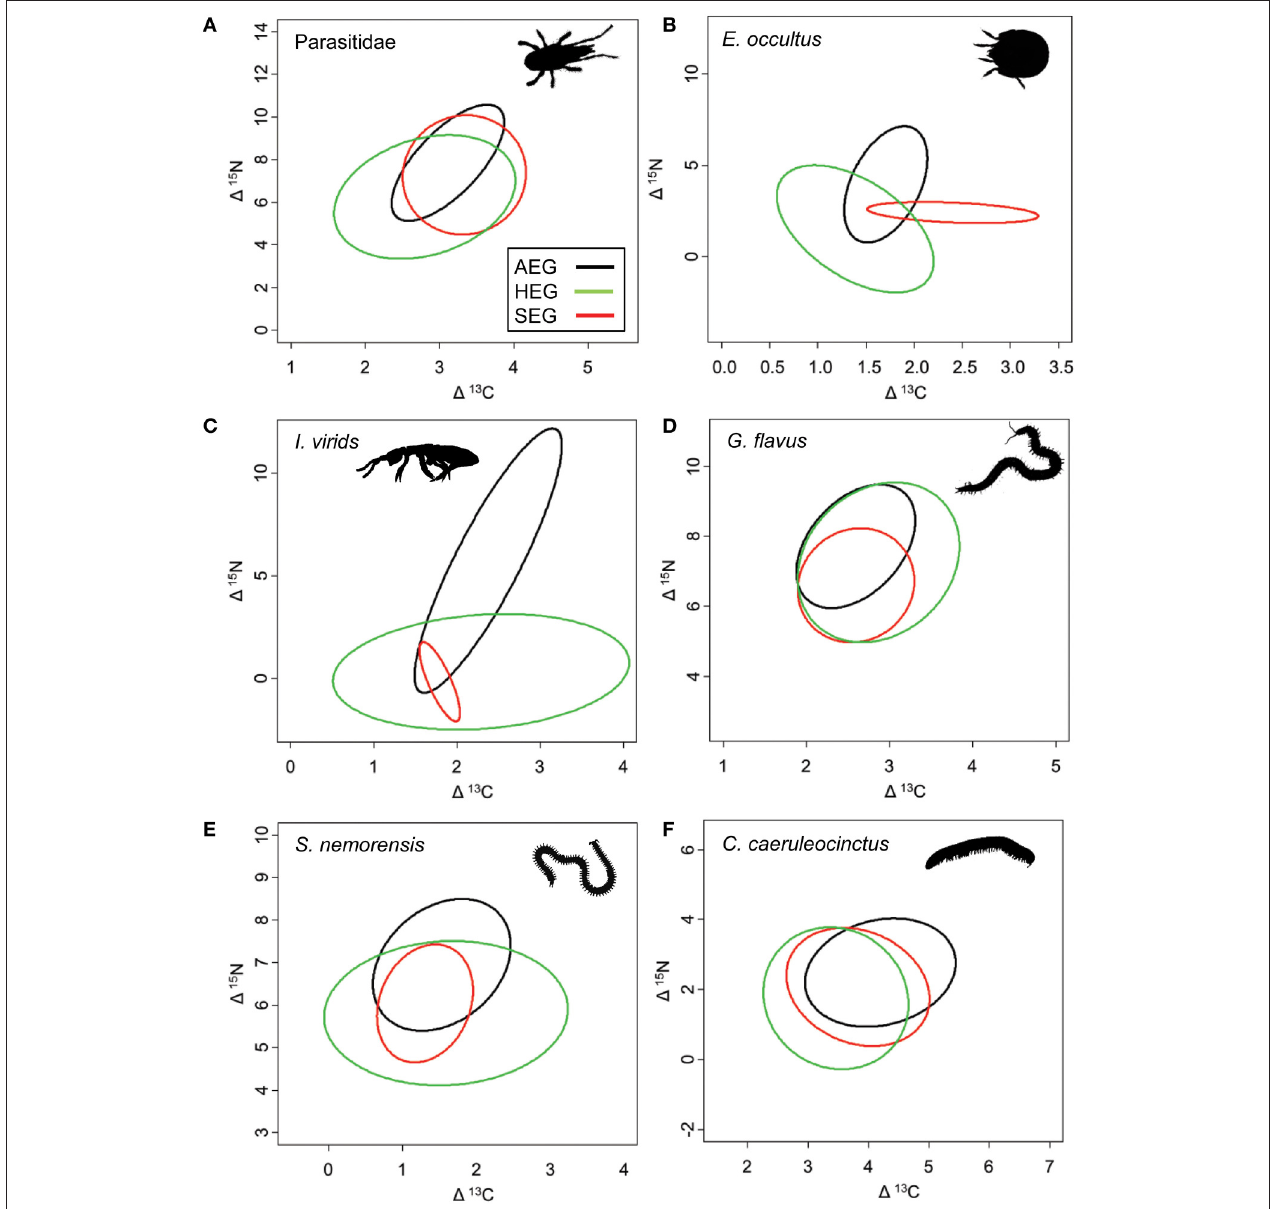
FIGURE 6 | Isotopic niches of the six soil arthropod species that were sufficiently common to calculate standardized ellipses for the feeding niches in all three study region (occurrence in a minimum of three sites per region; see Table 1 for location and abbreviation of sites). Note that standardized ellipses account for different sample sizes per region and are adjusted for small sample sizes (SEAc; Jackson et al., 2011). Taxa are (A) Parasitidae, (B) Eupelops occultus , (C) Isotoma viridis , (D) Geophilus flavus , (E) Schendyla nemorensis , and (F) Cylindroiulus caeruleocinctus